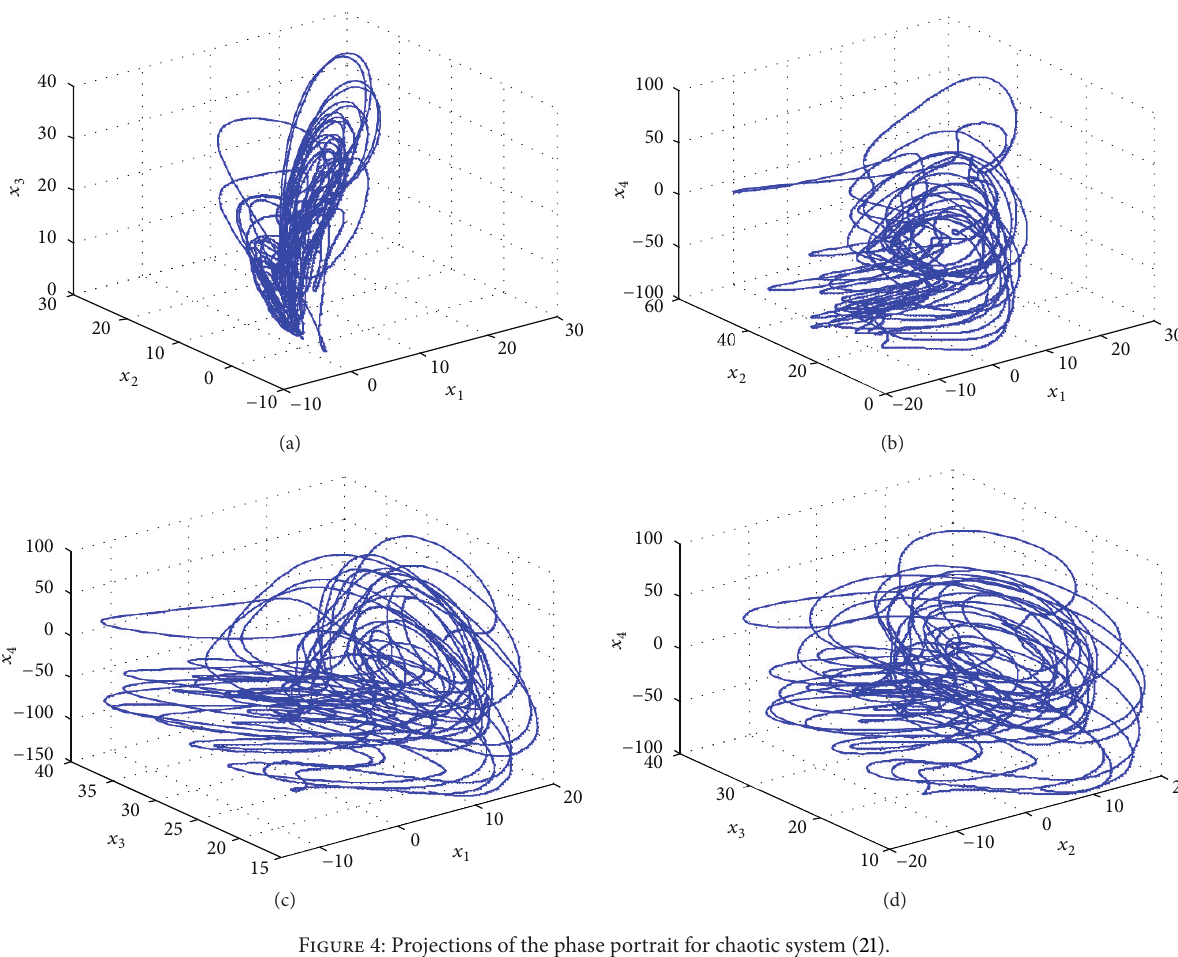
Figure 4: Projections of the phase portrait for chaotic system